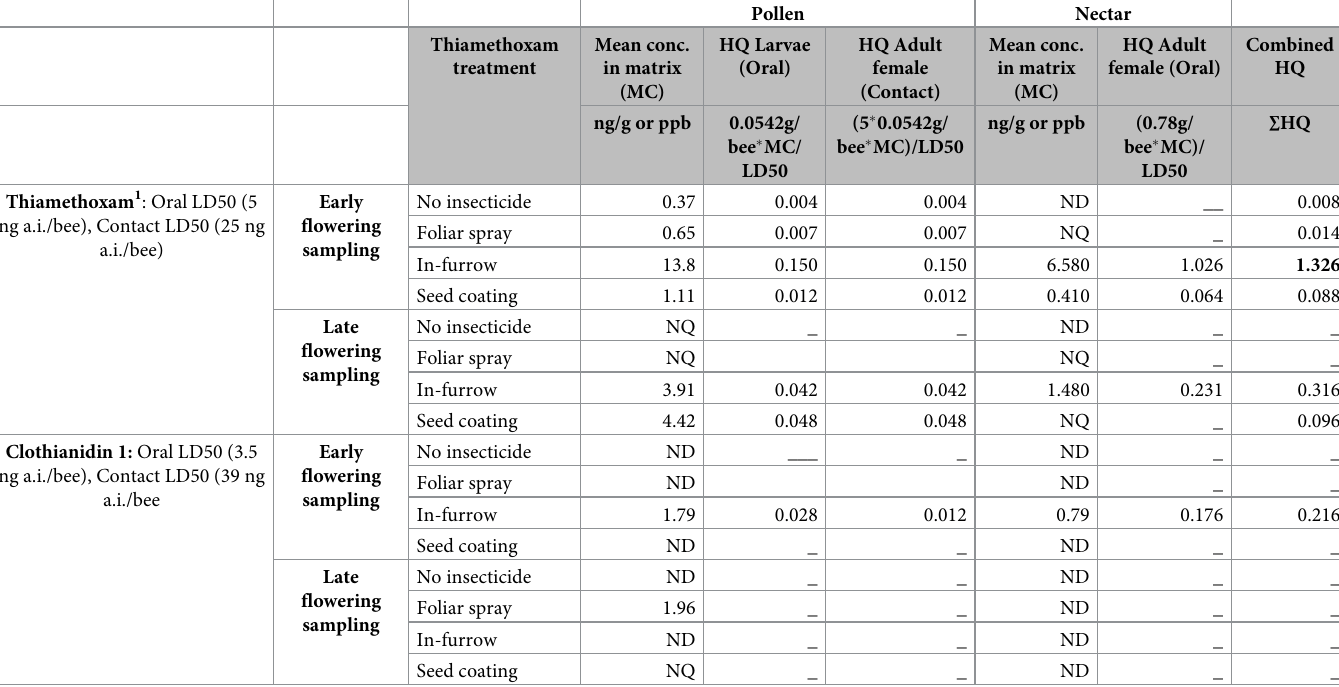
Table 4. Hazard quotients (HQ) estimated for Eucera (Peponapis) pruinosa with potential exposure to nectar and pollen from flowers produced early (July) and late (August) in the flowering period of squash plants treated with different thiamethoxam application